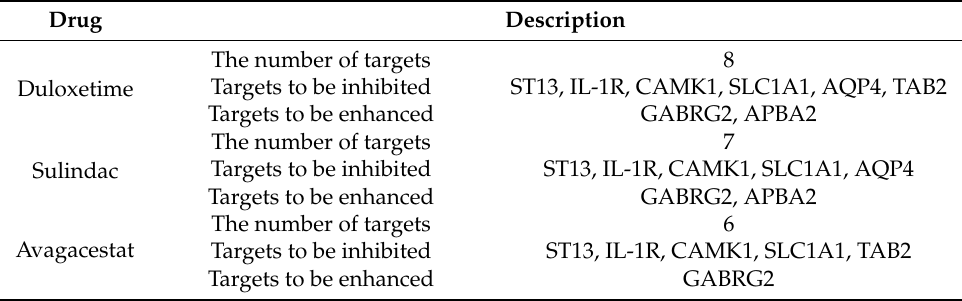
Table 1. The multiple-molecule drug for the early-stage AD. Drug